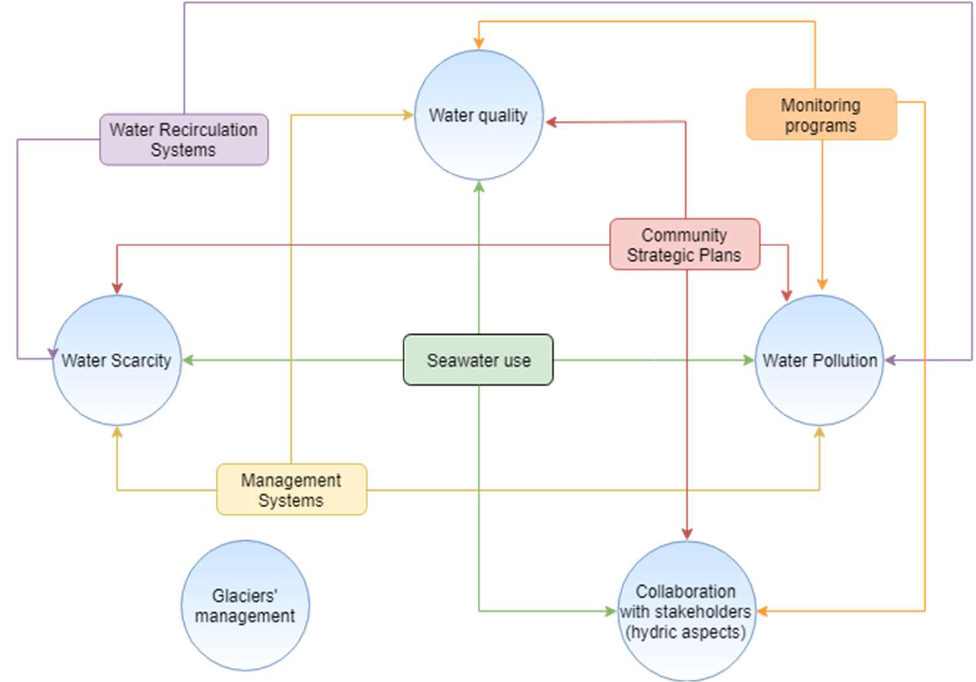
Figure 3. The relationship between water challenges and dominant initiatives used by copper mining companies in Chile.